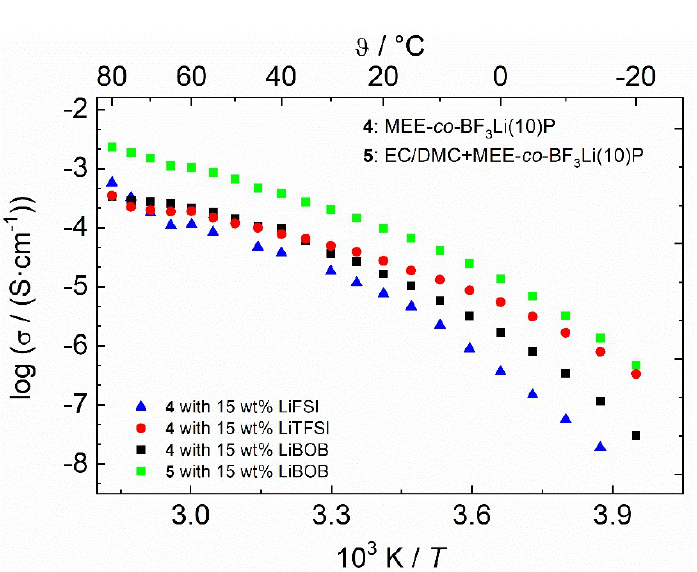
Figure 4. Arrhenius-plot of the cross-linked polymer 4 and 5 membranes with different lithium salts (15 wt %). (15 wt